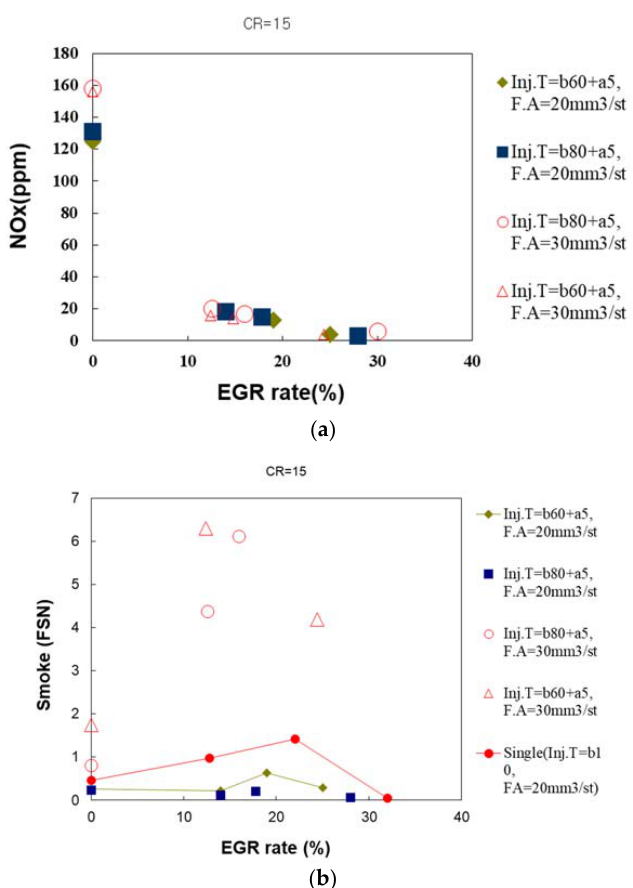
Figure 11. Performance characteristics of IMEP and emission applied to EGR (compression ratio: 15.0, 1400 rpm, injection amount: 20, 30 mm 3 /stroke). ( a ) NO x according to EGR rate; ( b ) Smoke according to EGR rate.